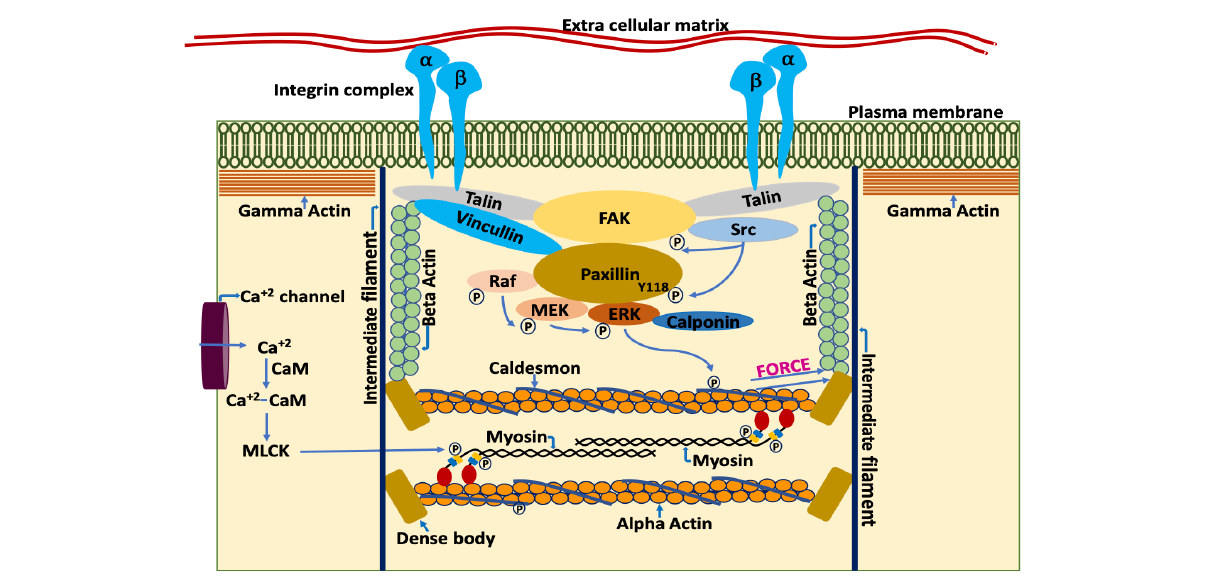
Figure 1. Schematic representation of components of the VSMC by which it regulates contractility and stiffness. The smooth muscle cell plasma membrane is spanned by FA complexes containing, among many other proteins, talin, vinculin, FA kinase (FAK), and integrins [52]. Cytoskeletal proteins of the FA complexes connect to the membrane-spanning integrins, composed of alpha and beta integrin heterodimers. On the cytoplasmic side, the FAs connect to the actin cytoskeletal filaments. Thus, the integrin complex connects the interior of the cell to the ECM allowing cell-matrix communication and signaling [53, 54]. Contractile force is generated by the actomyosin cross bridge cycle. During the cross-bridge cycle, force is generated by movement of myosin head domains while they are attached to the actin filaments. Acto-myosin cross bridge cycling is a tightly regulated process, involving both the thin and thick filaments. Thin filament regulation, in part, involves the blocking of myosin attachment sites on F-actin by caldesmon [55]. Caldesmon, in turn, is regulated by a complex, Src dependent signaling cascade. Src dependent phosphorylation of paxillin at Y118 allows the binding of rapidly accelerated fibrosarcoma (Raf) and extracellular signal-regulated kinase (ERK) to mitogen-activated protein kinase kinase (MEK) bound paxillin [56]. The formation of this complex leads to the activation of MEK by Raf and ERK transphosphorylation by active MEK. Subsequently, activated ERK translocates to, and phosphorylates, caldesmon [57]. Once phosphorylated, caldesmon undergoes a conformation change in its structure and no longer blocks the myosin attachment sites on F-actin. This sequence of events, then promotes acto-myosin interaction. However, attachment of the myosin head to F-actin is also regulated by phosphorylation of the myosin regulatory light chain (MLC), leading to additional signaling cascades described as thick filament regulation [58]. For example, increased intracellular calcium levels during agonist- induced opening of calcium channels in the plasmalemma leads to the formation of calcium-calmodulin complexes which then activates myosin light chain kinase (MLCK) [59-61]. Active MLCK then phosphorylates the myosin light chains which activates myosin ATPase activity [62]. Increased myosin ATPase activity leads to a conformational change in the head of myosin and promotes the attachment of myosin to actin in the strong binding conformation. Force generated during acto-myosin interaction is transmitted to dense bodies and through the nonmuscle actin cytoskeleton, to FA complexes, including the transmembrane integrins and, subsequently, to the ECM and the vessel wall [46, 63]. Simultaneous contraction of the VSMCs in the vessel wall leads to vascular constriction, which, when increased in extent or duration also leads to increased pathologies of hypertension and vascular stiffness